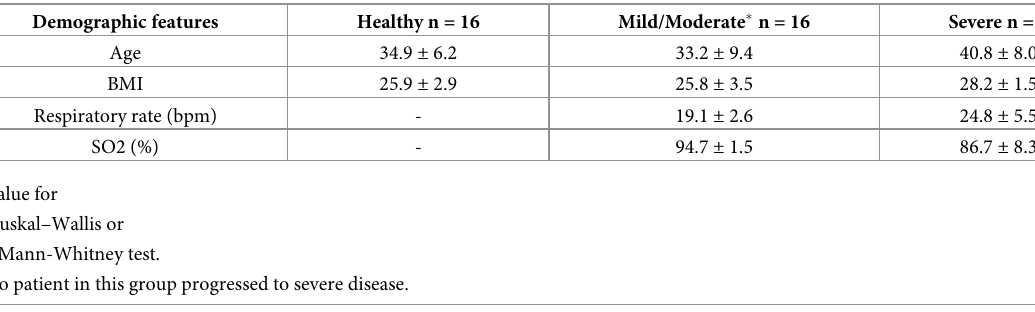
Table 1. Main demographic features of the patients included in the